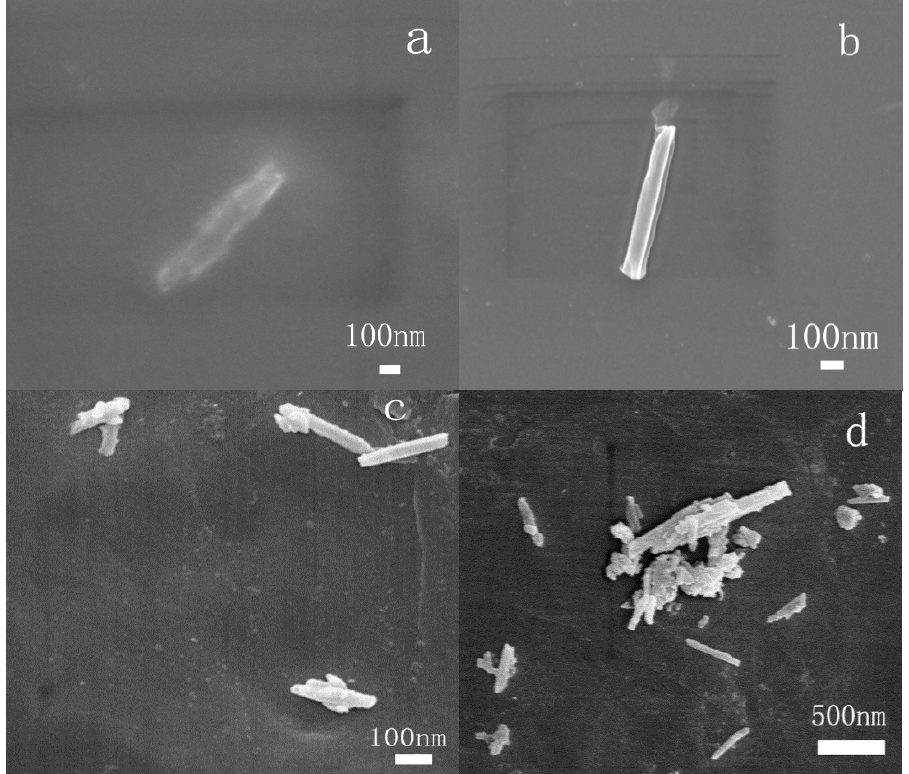
Figure 5. SEM of PI-HNTs-1% ( a ), PI-PHNTs-1% ( b ), PI-HNTs-3% ( c ), and PI-HNTs-5% ( d ).